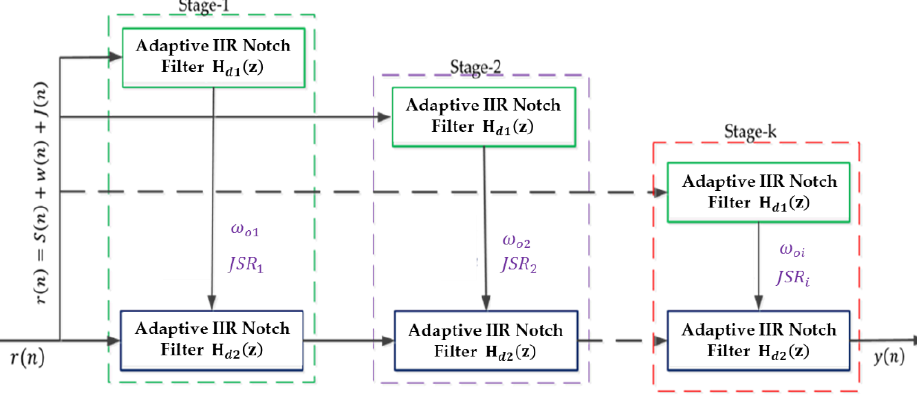
Figure 5. The suppression system model of the MANF block diagram.